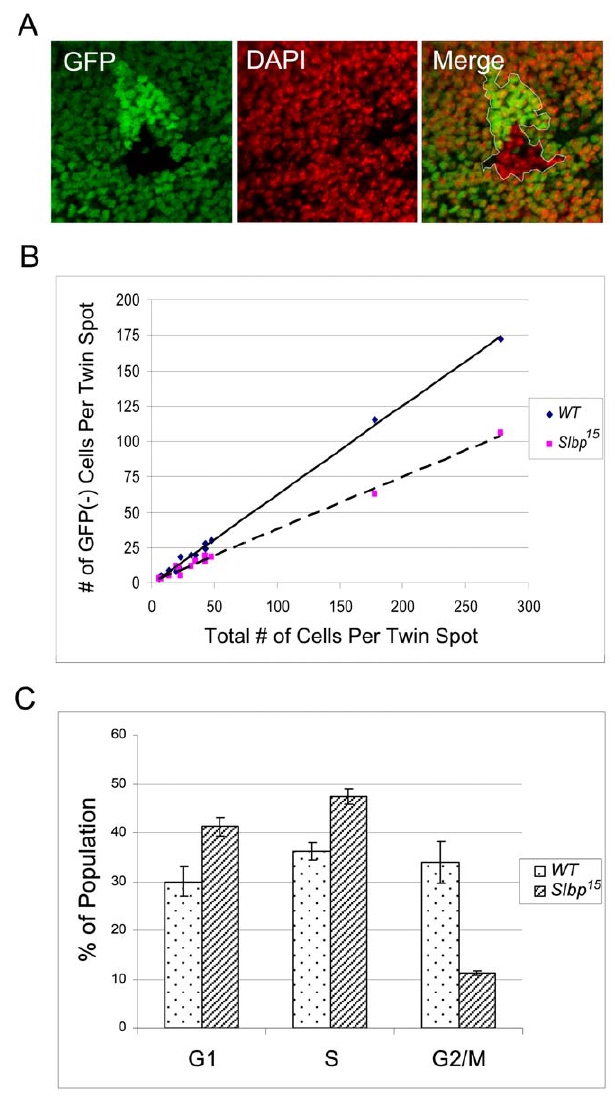
Figure 6. Slbp mutants exhibit a cell proliferation defect. A) Mitotic clones from Slbp 15 /Ubi:GFP-nls 3 rd instar larvae are visualized with native GFP signal and stained with DAPI. B) Cell counts of wt or Slbp 15 mutant GFP negative cells plotted against the total number of cells in each twin spot with accompanying trend line for each genotype. A solid line indicates wt , dashed indicates Slbp 15 . For the number of twin spots analyzed, (n=13) P-values are indicated as follows: * p , 0.05 and n.s.=not significant. C) FACS analysis of wt and Slbp 15 mutant wing discs from wandering 3 rd instar larvae. Each bar represents the mean of three independent experiments where over 4,000 cells were analyzed per genotype. P-values are indicated as follows: ***p , 0.001. Error bars indicate